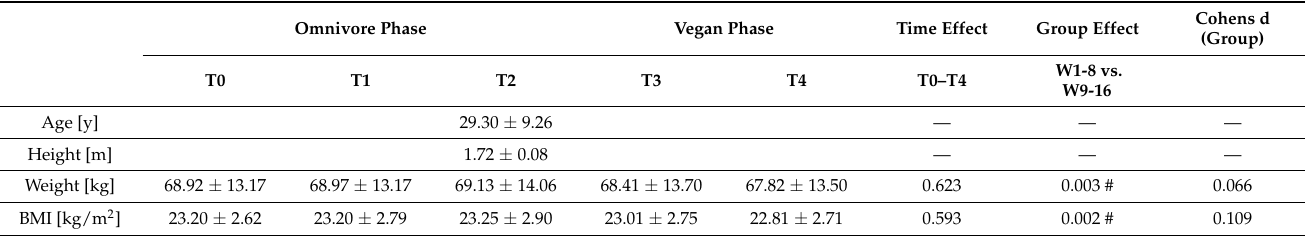
Table 1. Anthropometric